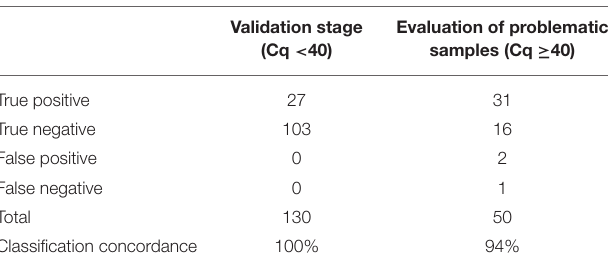
TABLE 5 | Evaluation of the clinical performance of direct RT-qPCR protocol compared to the standard protocol as reference. Validation stage (Cq <